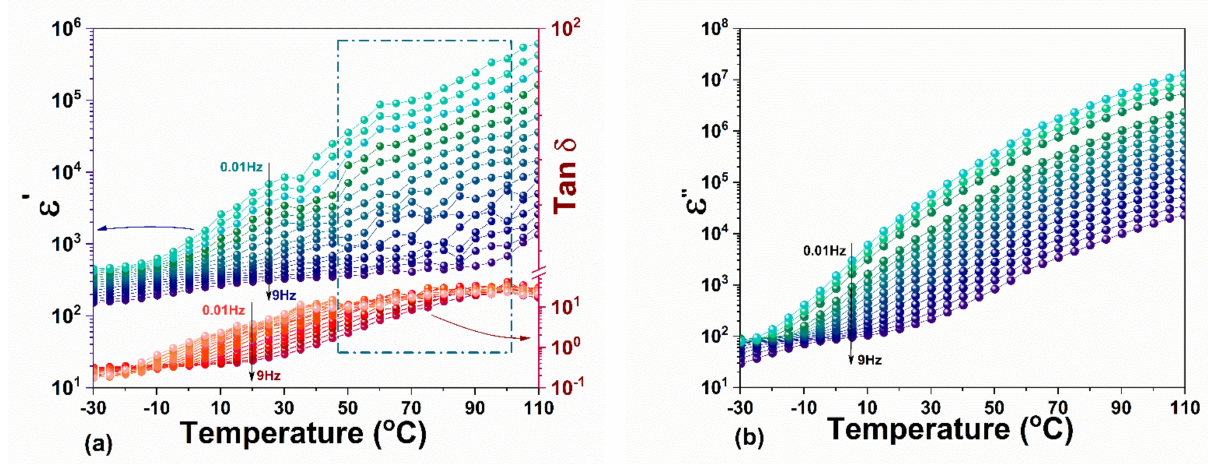
Figure 11. The temperature dependence of ( a ) the dielectric permittivity ε (cid:48) and loss tangent tan δ and ( b ) the loss factor ε ” measured during heating and cooling in the frequency ranges of 0.01 Hz ÷ 10 Hz (for the full frequency range up to 10 MHz see Figure S3 in Supplementary